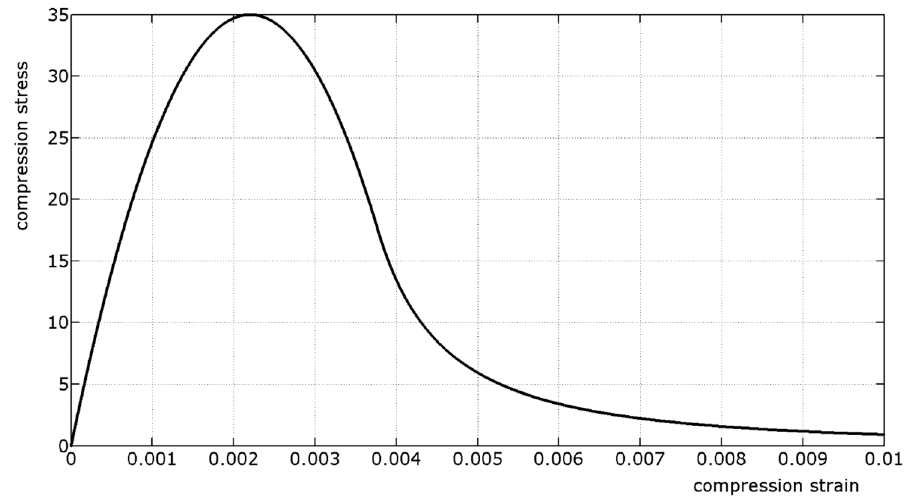
Figure 2. σ c – ε c relationship for uniaxial compression of concrete, described by Equations